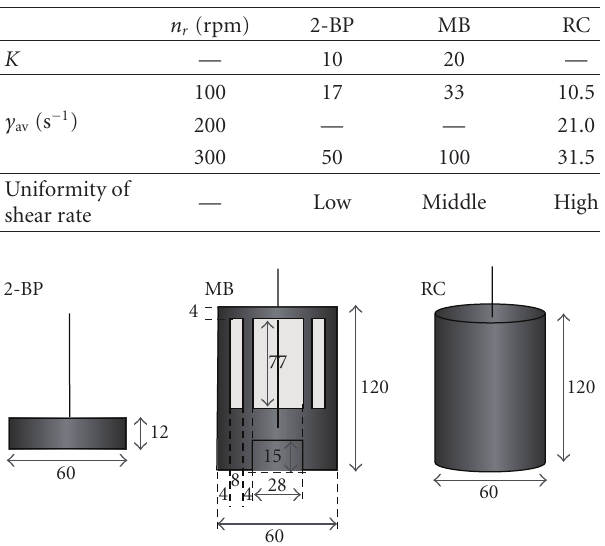
Figure 1: The schematic illustration of three types of impellers used in the present study (the unit of length is